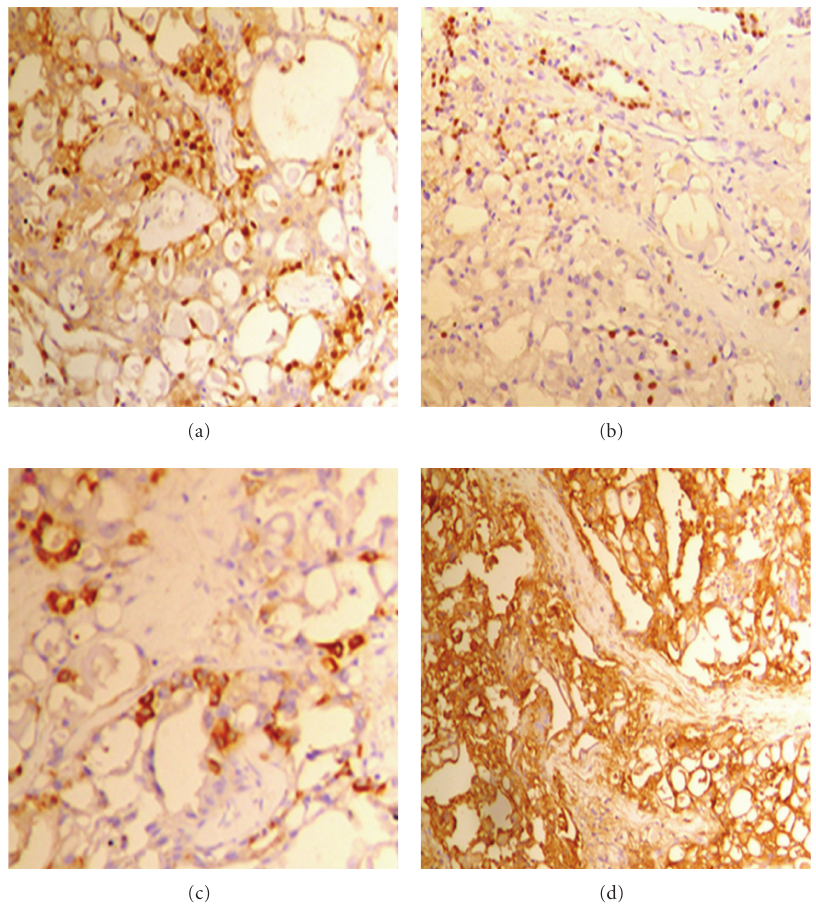
Figure 2: The tumor cells show positive nuclear and cytoplasmic staining by S100 antibody (a) positive cytoplasmic staining by EMA antibody, (b) positive cytoplasmic staining by pan cytokeratin, (c) and some showed positive nuclear staining by ER antibody